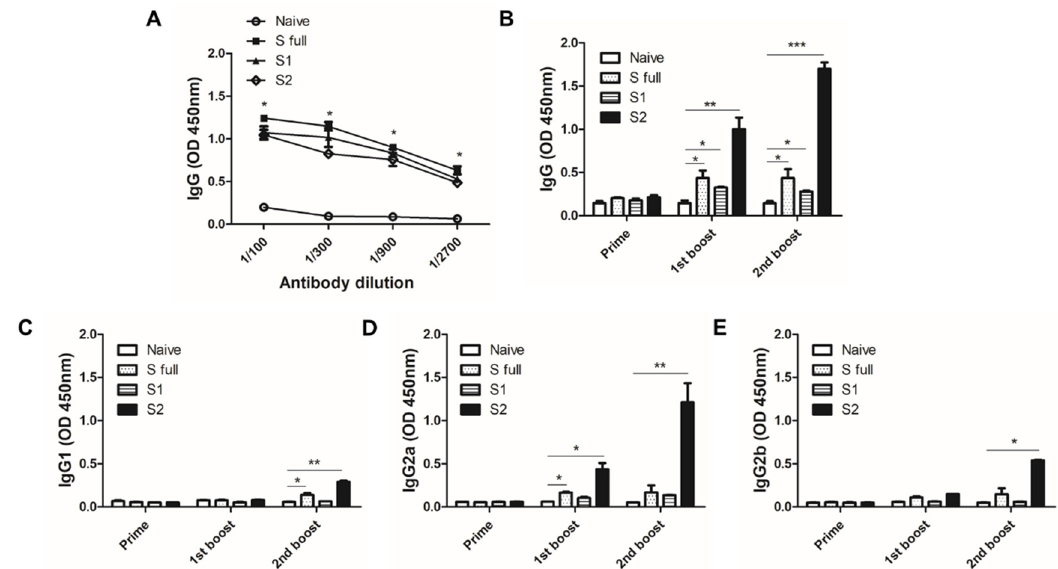
Figure 6. Antigen-specific antibody responses induced by VLP immunization. Sera of mice were collected 1 week after each immunization and were used to assess the antigen-specific antibody responses via ELISA. VLP immunization and boosting effect of VLP immunization was confirmed by reacting the sera against S full VLP ( A ). All of the sera collected over the course of the animal studies were used to observe changes in IgG ( B ), IgG1 ( C ), IgG2a ( D ), IgG2b ( E ) responses against S1 and S2 antigens. Data are expressed as mean ± SEM (* p < 0.05, ** p < 0.01, *** p < 0.001).